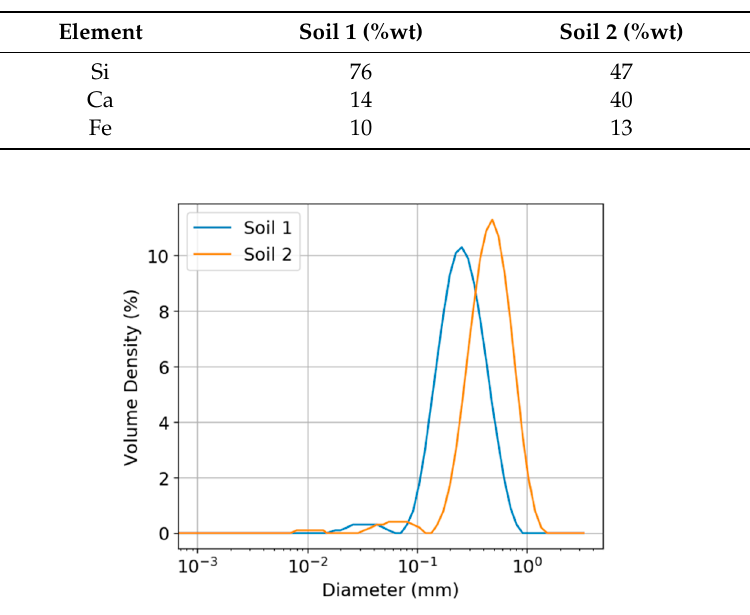
Figure 1. X-ray diffraction patterns of soil 1 sampled from the Rotem Plateau. Counts in arbitrary units. Table 1. Elemental composition X-ray fluorescence (XRF) of soils from the Rotem Plateau.